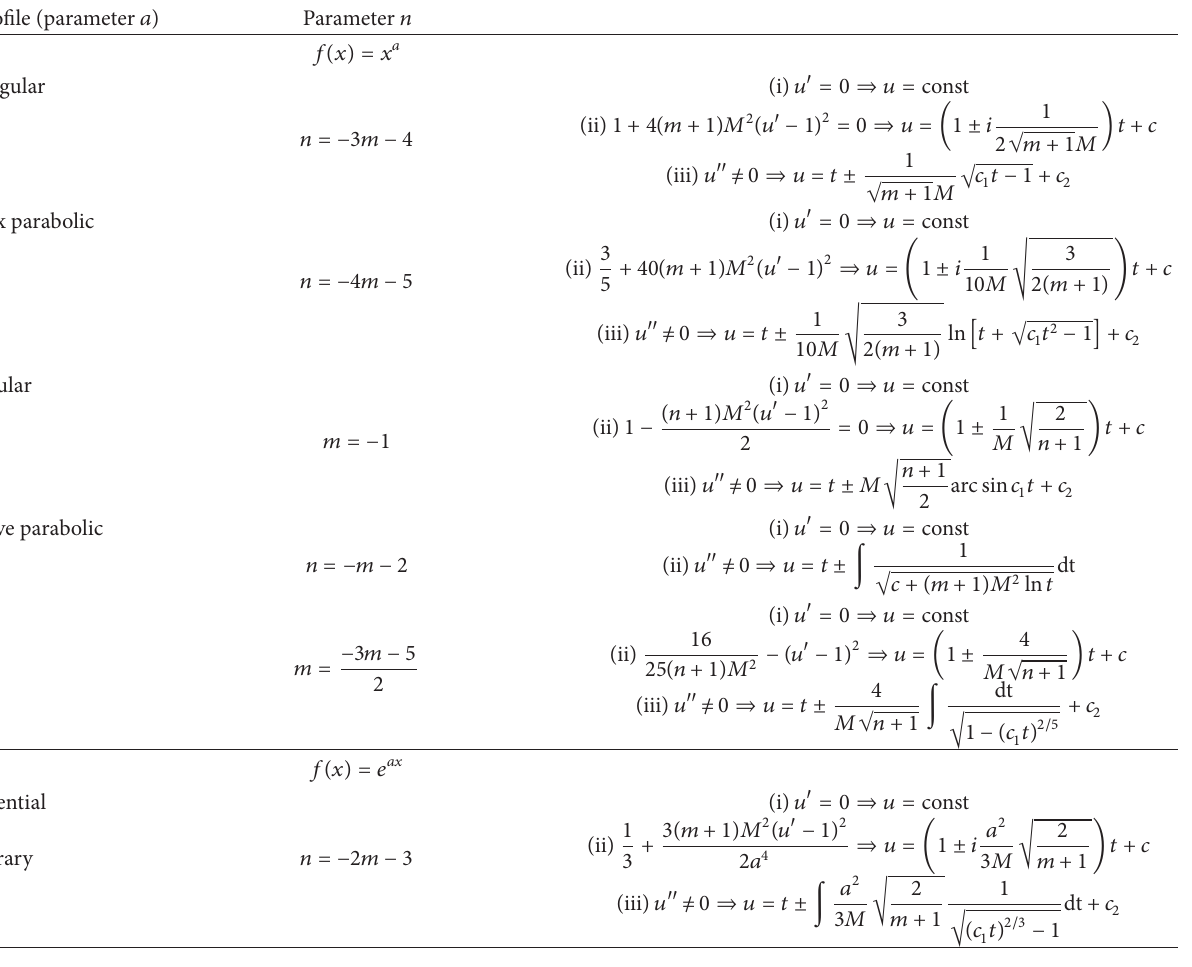
Table 12: Reductions arising from Table 9.